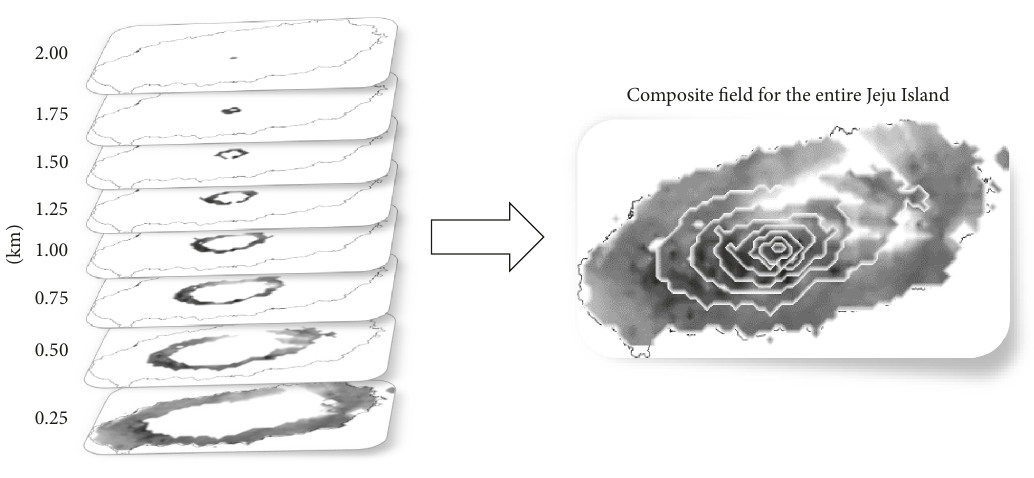
Figure 5: Construction of radar reflectivity field over the Jeju Island using the radar CAPPI data (radar data observed at 2014/08/02/05:00).